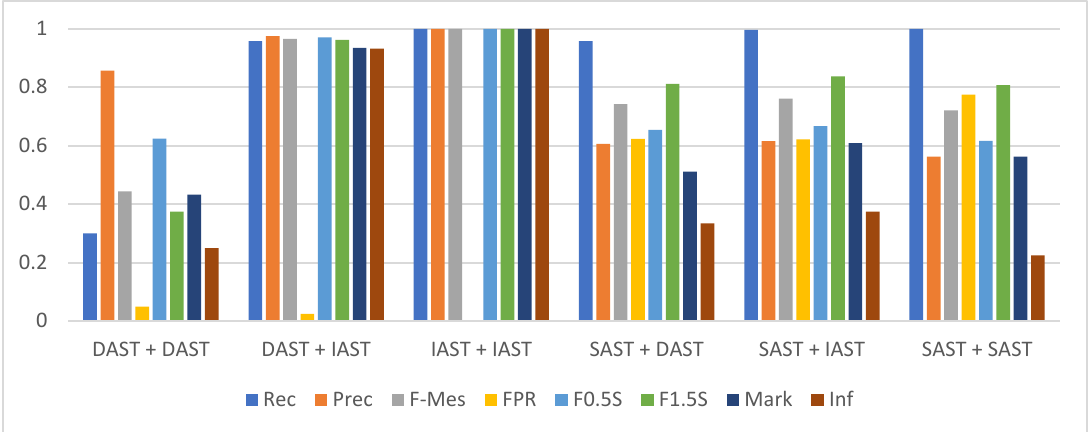
Figure 5. Metric results comparison of 2-tools combinations.